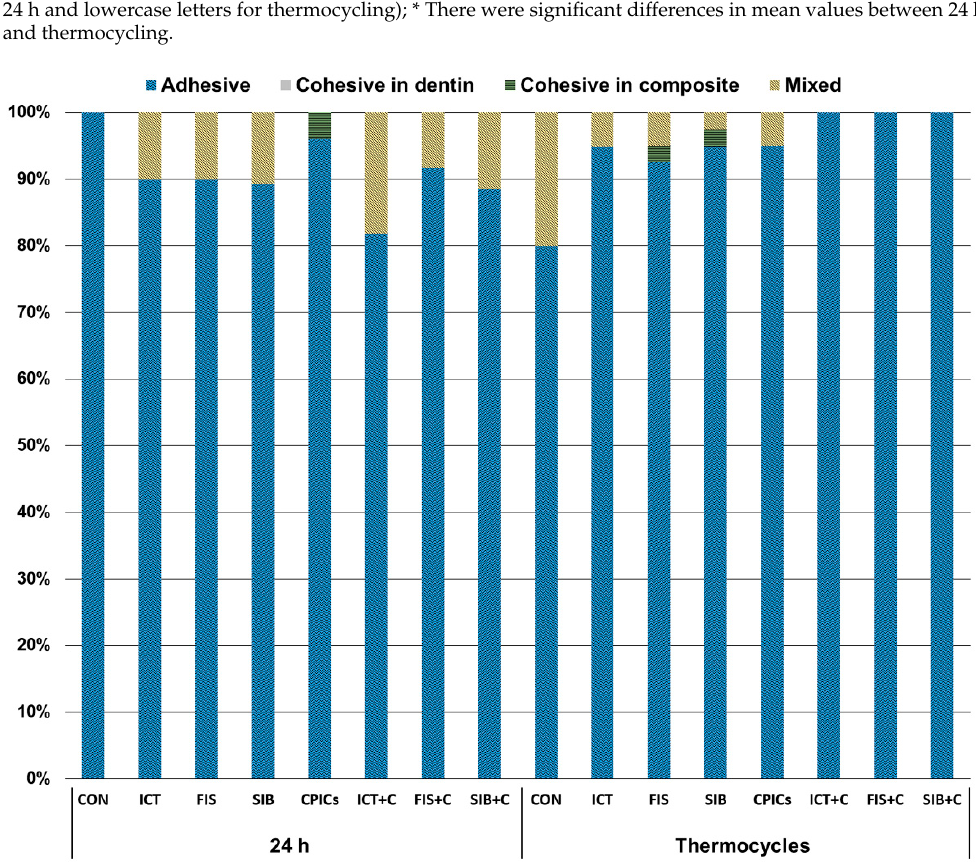
Figure 3. Distribution of failure modes after the microtensile bond strength test.